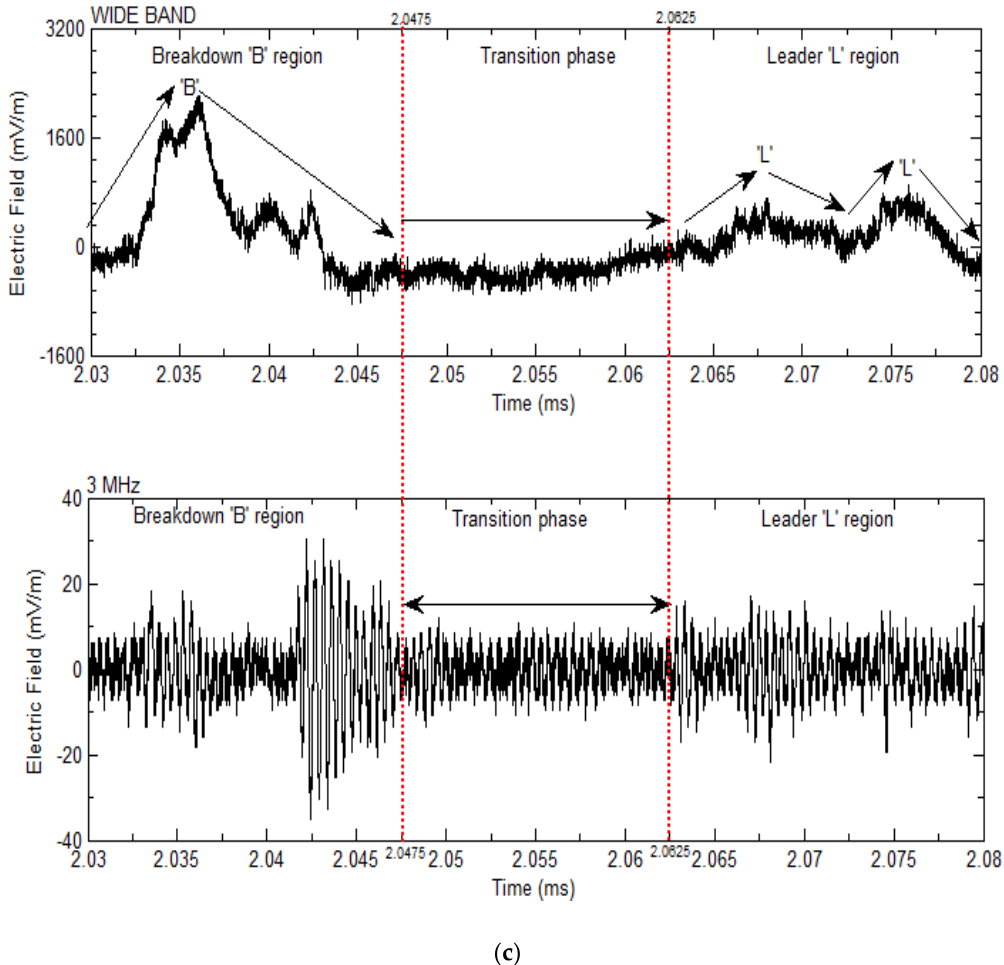
Figure 1. Simultaneous electric field records of negative cloud-to-ground lightning flash at wide bands and at 3 MHz. ( a ) A typical example of “B” “I” “L” type flash that was recorded on 19/07/2014 at 16:05:22:005374. Total time frame of the record was 250 ms but only 5 ms from the trigger time is shown and the distance to the strike location (60.08570°N, 17.27850°E) was 30 km from the measuring station. Note that the pulses around the transition from “B” to “I” and from “I” to “L” are shown in a smaller time window of 0.02 ms. ( b ) An example of “B” “L” type structure recorded on 19/07/2014 at 15:48:45:303558. The record length was 250 ms but only 3 ms from the trigger time is shown and the strike location (60.22760°N, 17.48430°E) was 34.39 km away. In the inset, the transition between “B” and “L” are shown. ( c ) Pulse structure around the transition from “B” to “L” in the case of “B” “L” type structure (shown in Figure 1b) is shown in a 0.05 ms time window. Table 2. Statistical presentation of the temporal features of preliminary breakdown (PB) pulses.